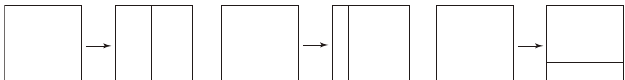
Figure 2. Elements of the resolution transformation process based on a simple partitioning